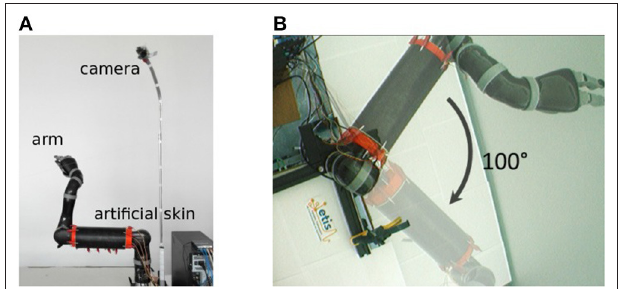
FIGURE 2 | Experimental setup used in our experiments. (A) Robot arm covered with the artificial skin and firewire camera fixed in height. (B) Visual field of the camera and aperture angle of 100 ◦ of the robot